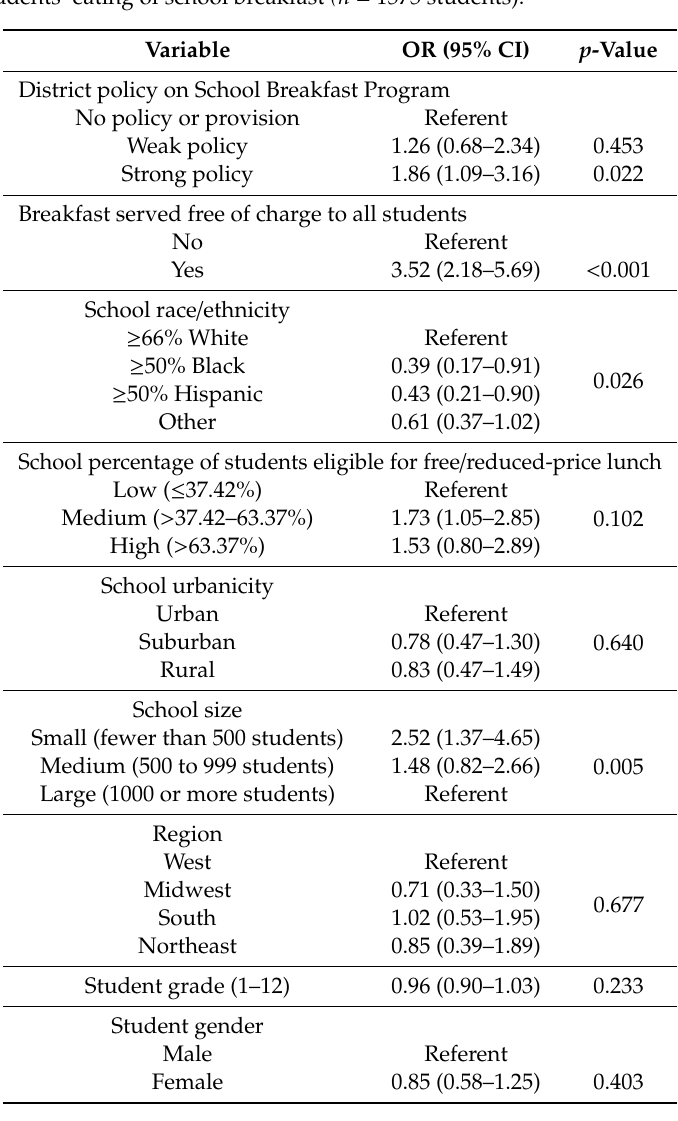
Table 2. Logistic regression results for the association between district policy on the School Breakfast Program and students’ eating of school breakfast (n = 1575